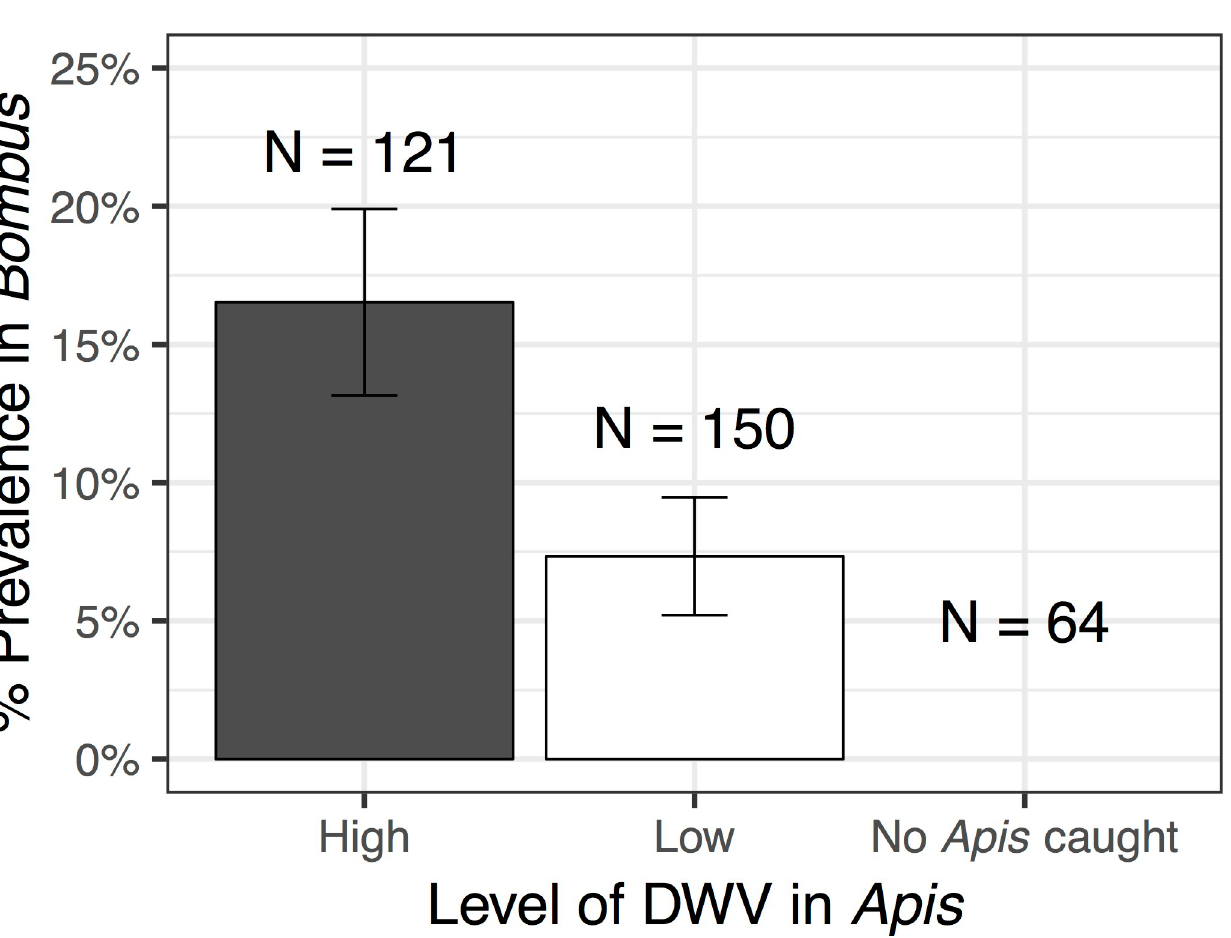
Fig 2. Percent prevalence for bumblebees infected with deformed wing virus (DWV) at sites where honeybees had high and low viral loads, and sites where no honeybees were present and therefore could not be collected. DWV was more prevalent in bumblebees caught at sites with honeybees with high average viral loads, than sites with honeybees with low average viral loads. Standard error bars are shown.